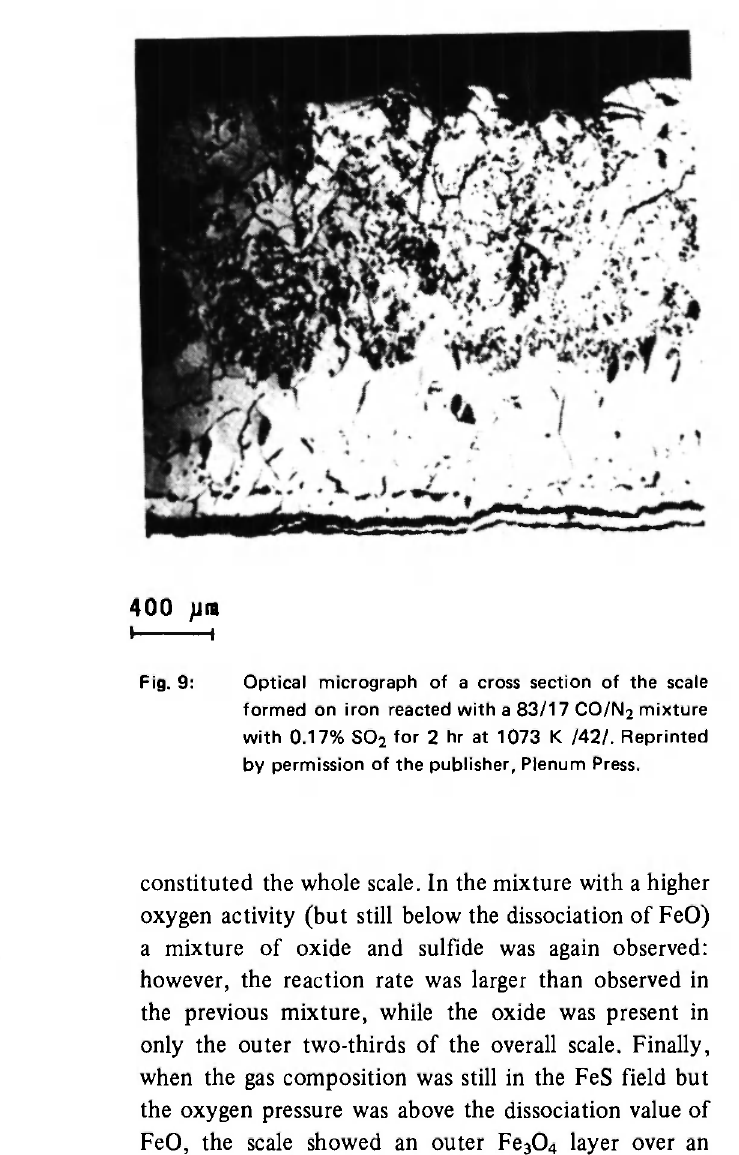
Fig. 9: Optical micrograph of a cross section of the scale formed on iron reacted with a 83/17 CO/N 2 mixture with 0.17% S0 2 for 2 hr at 1073 Κ /42Λ Reprinted by permission of the publisher, Plenum